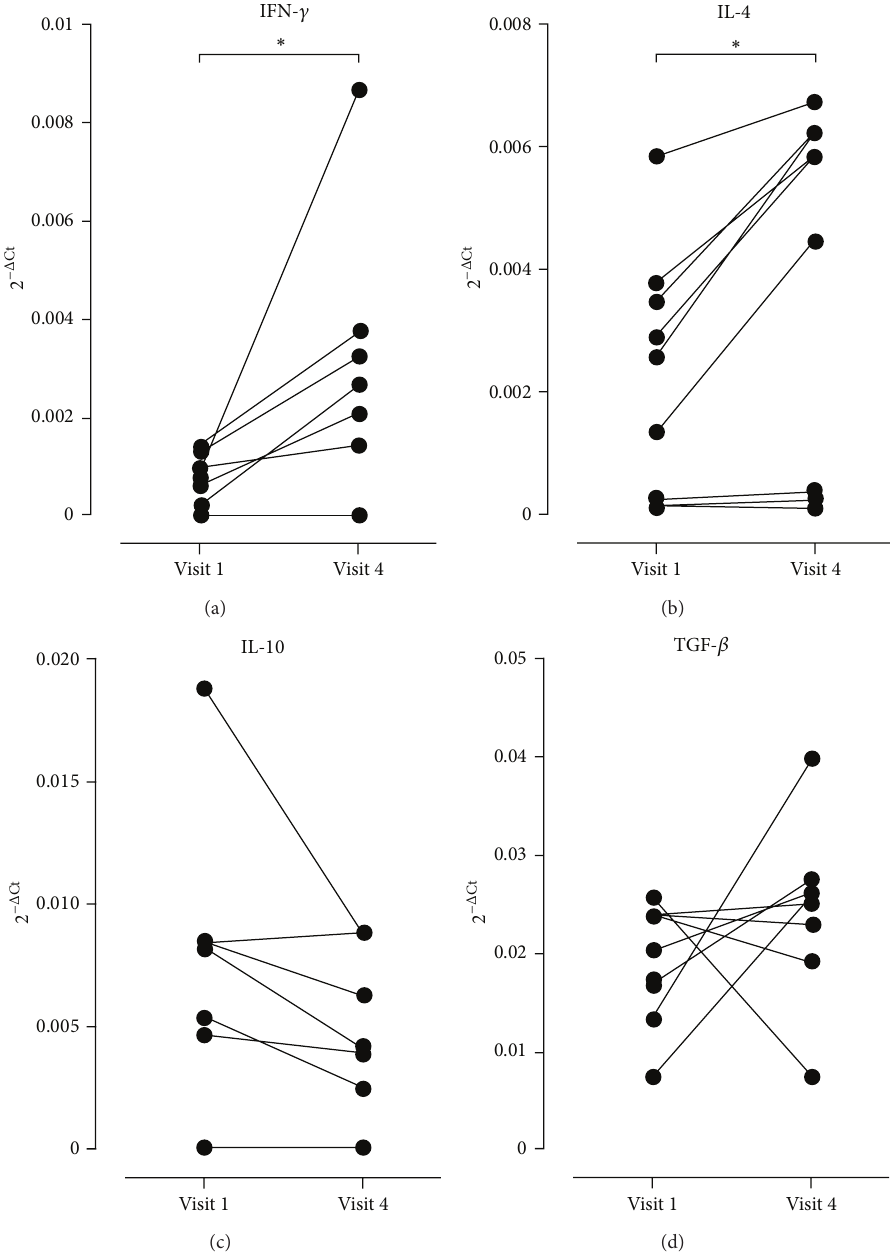
Figure 2: IFN- 𝛾 , IL-4, IL-10, and TGF- 𝛽 mRNA levels in PBMCs obtained from venous blood of PAD patients at visit 1 and visit 4. ∗ = 𝑃 < 0.01 versus visit 1.